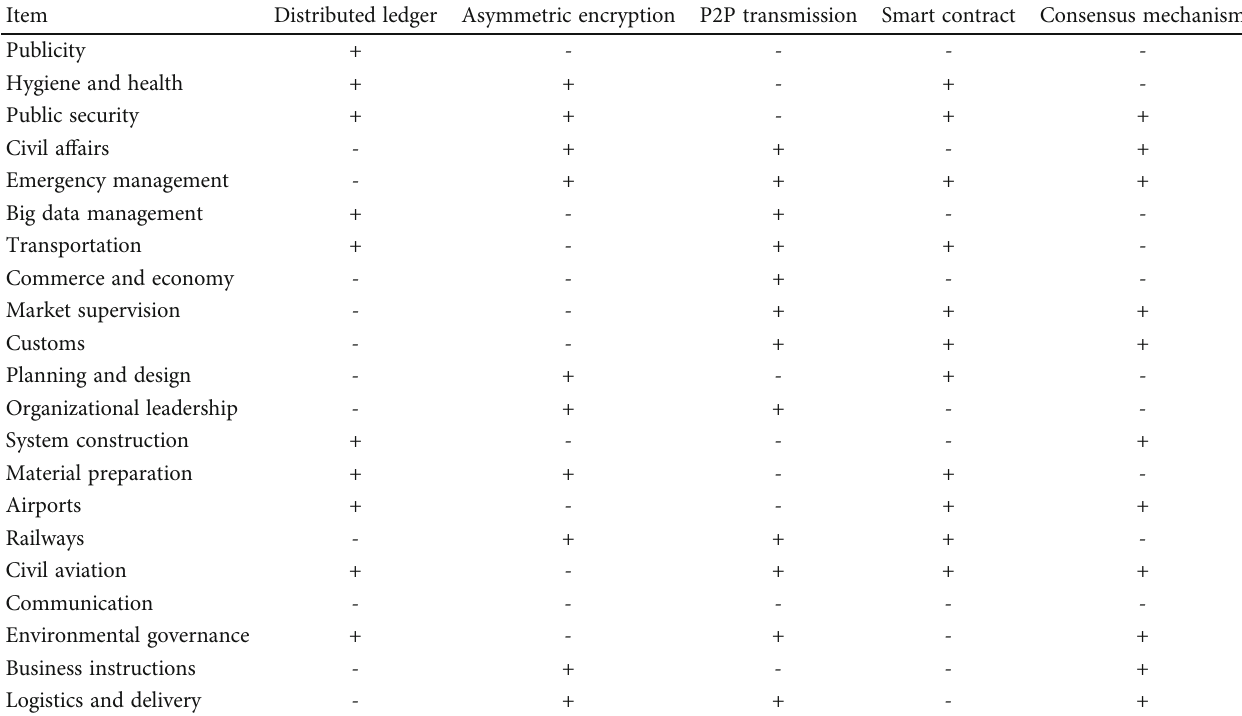
Table 1: Blockchain characteristics in the public administration and resource allocation of the prevention and control of COVID-19 epidemic (note: +: have; -: does not